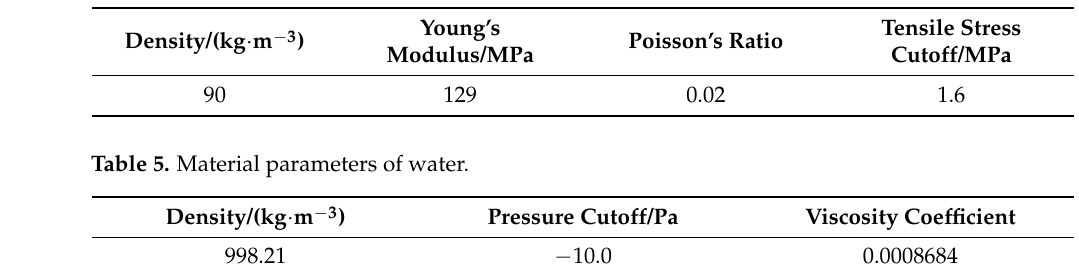
Table 4. Material parameters of buffer.